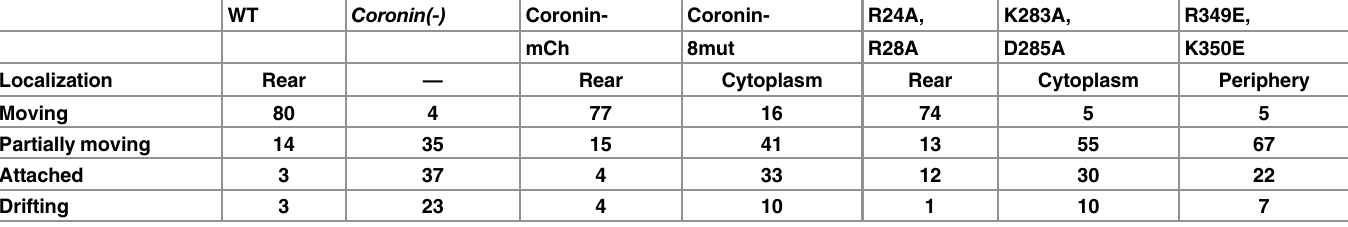
Table 3. Comparison of different parasite lines with different coronin mutants for the percentage of sporozoites showing localization of coronin- mCherry and different movement patterns. The localization is classified as rear, peripheral and cytoplasmic, while the movement pattern is classified as moving, partially moving, attached and